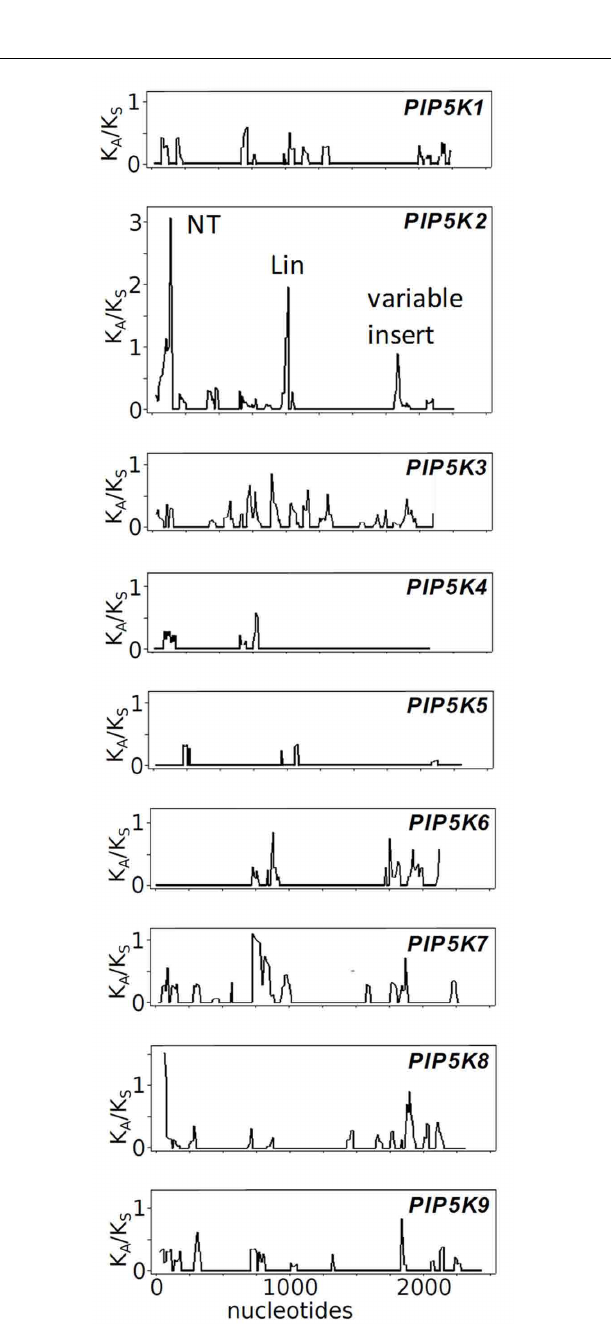
FIGURE 9 | Rate of evolution of Arabidospis thaliana PI4P 5-kinase sequences according to sliding window analysis of K A / K S ratios comparing orthologous sequences of A. thaliana and A. lyrata . The rate of sequence evolution across the coding sequence of AtPIP5K1-9 was assessed by comparing the A. thaliana sequences to orthologous sequences from A. lyrata .The sliding window analysis depicts the ratios of the number of non-synonymous substitutions per non-synonymous site ( K A ) to the number of synonymous substitutions per synonymous site ( K S ). All plots are drawn to the same scale. Increased K A / K S ratios in sequence regions of AtPIP5K2 encoding the NT-domain, the Lin-domain and the variable insert region are annotated in the AtPIP5K2 plot, as indicated.The pairs of orthologous genes from A. thaliana and A. lyrata used for the analysis are given in the Section “Materials and